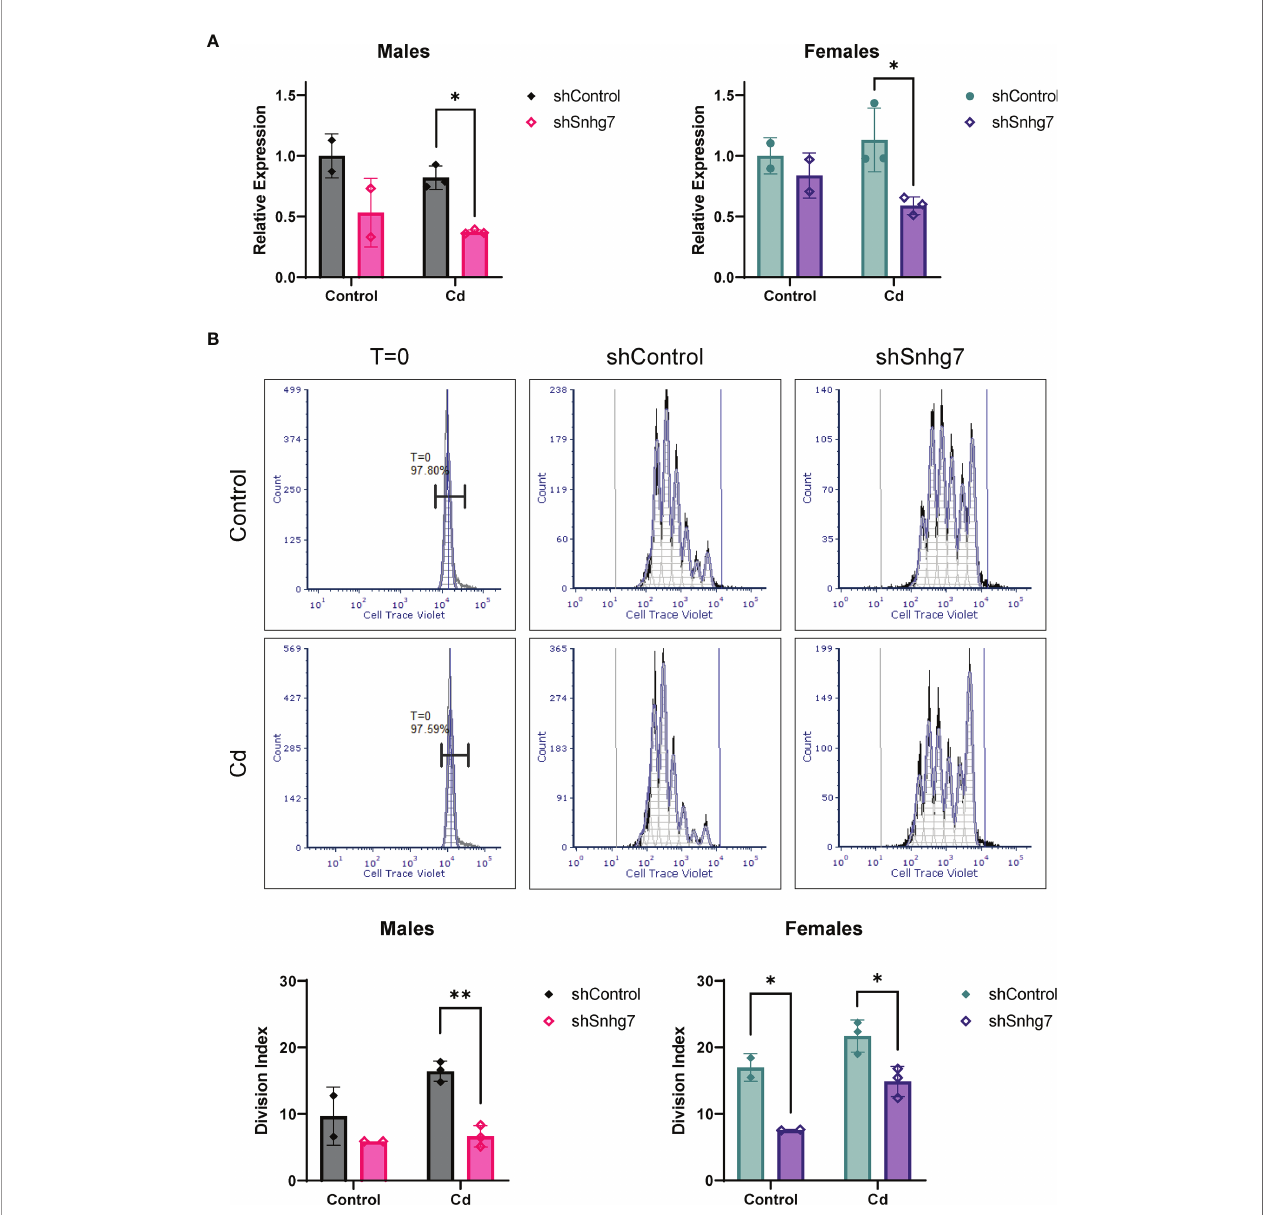
FIGURE 6 | Knockdown of lncSnhg7 inhibits proliferation in primary T cells from control and Cd offspring. Primary CD4 + T cells were isolated from mice splenocytes and labeled with Cell Trace Violet. T cells were stimulated with anti-CD3/CD28 magnetic beads in the presence of control- or lncSnhg7-targeted lentivirus for 18 h. Media was replaced, and stimulation proceeded for 72 h total before analysis. (A) lncSnhg7 expression was assessed by qPCR. (B) Cell Trace Violet expression was measured by fl ow cytometry and proliferation was modeled using FSC Express software. Representative proliferation histograms are shown for T=0 (unstimulated), control, and lncSnhg7 knockdown samples in Control and Cd offspring. The Division index is reported for each sample. Groups were compared using t-tests between shControl and shSnhg7 samples with correction for multiple comparisons using the Holm-S ̌ ı ́ da ́ k method in post-hoc analysis. *p < 0.05, **p < 0.01. n=2-3 per